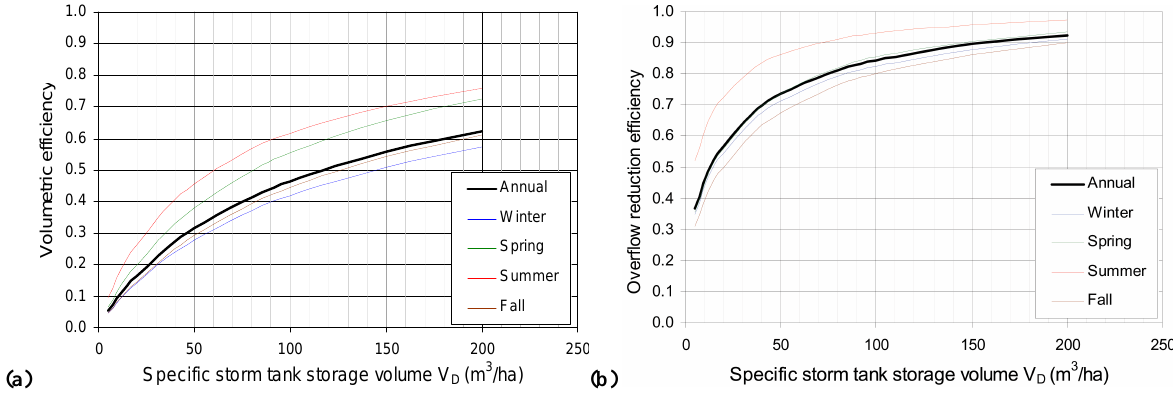
Fig. 8. Comparison between probabilistic model and continuous simulation results.